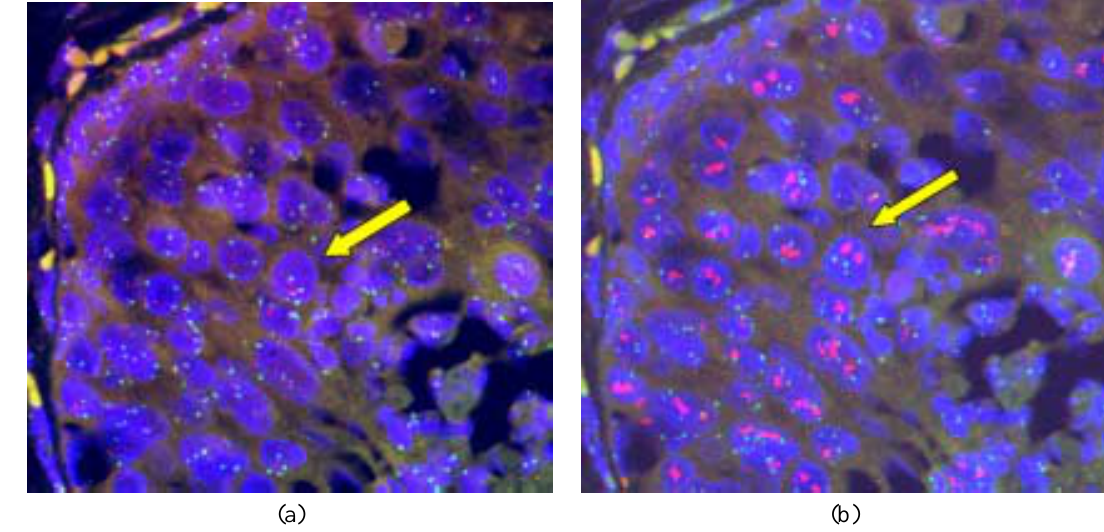
Fig. 1. ‘Sequential FISH’ on a DCIS lesion in a 5 µ m thick histological section, enabling detection of genetic alterations on the very same nuclei (arrows); (for methodology see [49]). (a) Cyclin D1 (red) and centromere 11 (green fluorescence) show both increased signal frequencies, demonstrating polysomy of the whole chromosome 11. (b) Increased signal counts are demonstrated for centromere 17 (green), indicating polysomy of the chromosome. Also an increased frequency was found for the oncogene c-erbB-2 (red fluorescence), which shows additionally distinct large clusters of the amplified oncogene. This figure can be viewed in colour on